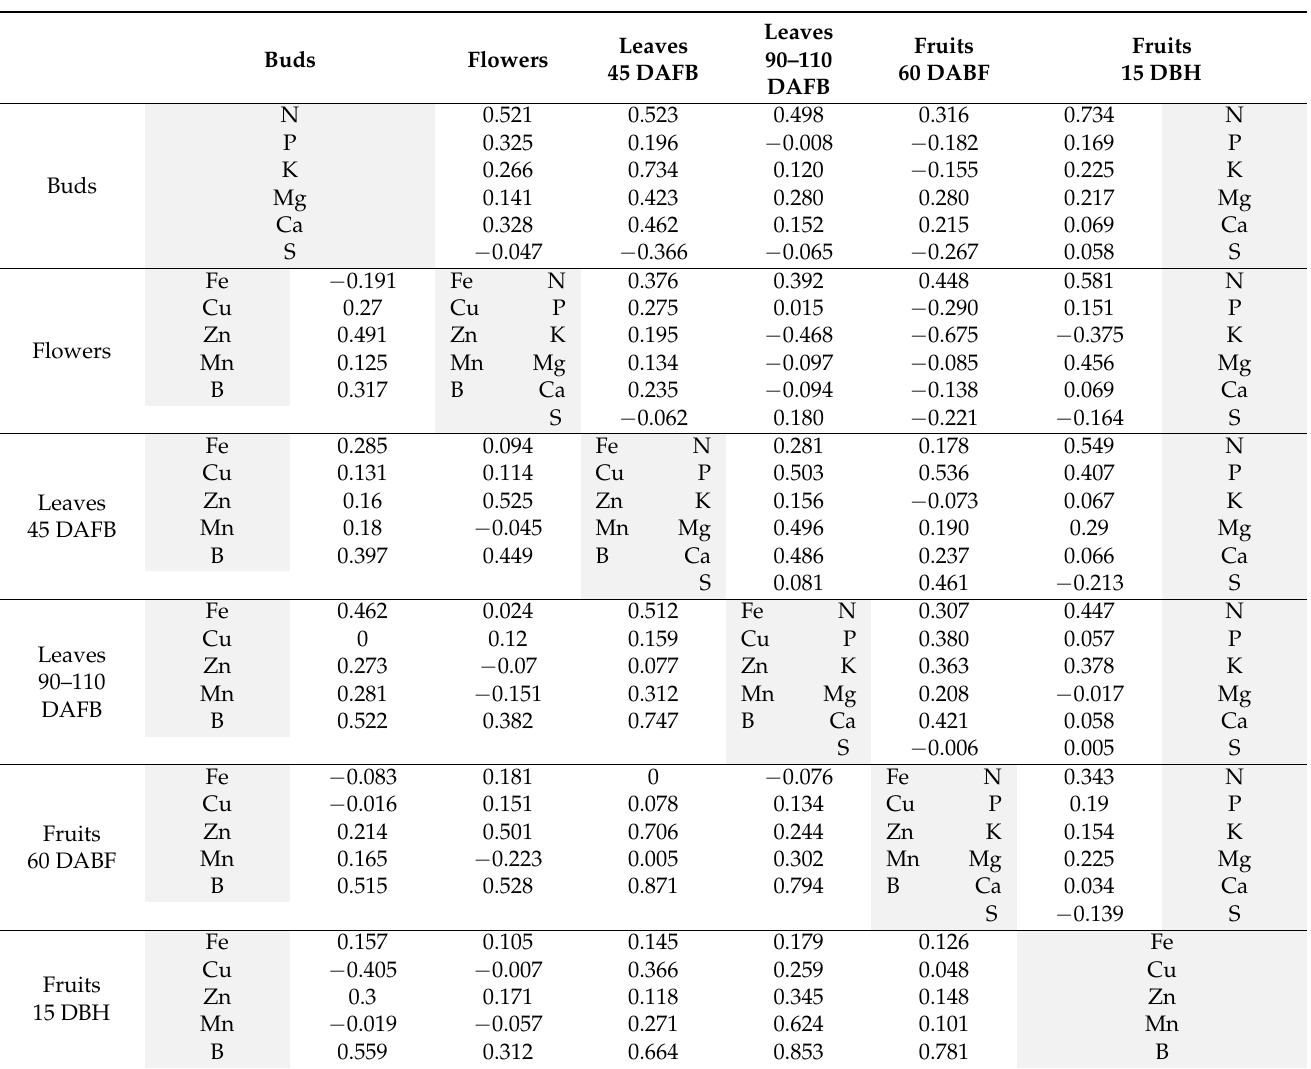
to Table 4, the correlation coefficients between 90 and 110 DAFB leaves and bud, flower and 45 DAFB leaves were weak for all macronutrients. Table 4. Pearson correlation coefficients for the content of each element in all pairs of organs ( n = 180. The top triangle contains the macronutrient correlations and the bottom triangle contains the micronutrient correlations. Only correlations whose absolute value is less than 0.123 are not significantly different from zero (at a 5% significance